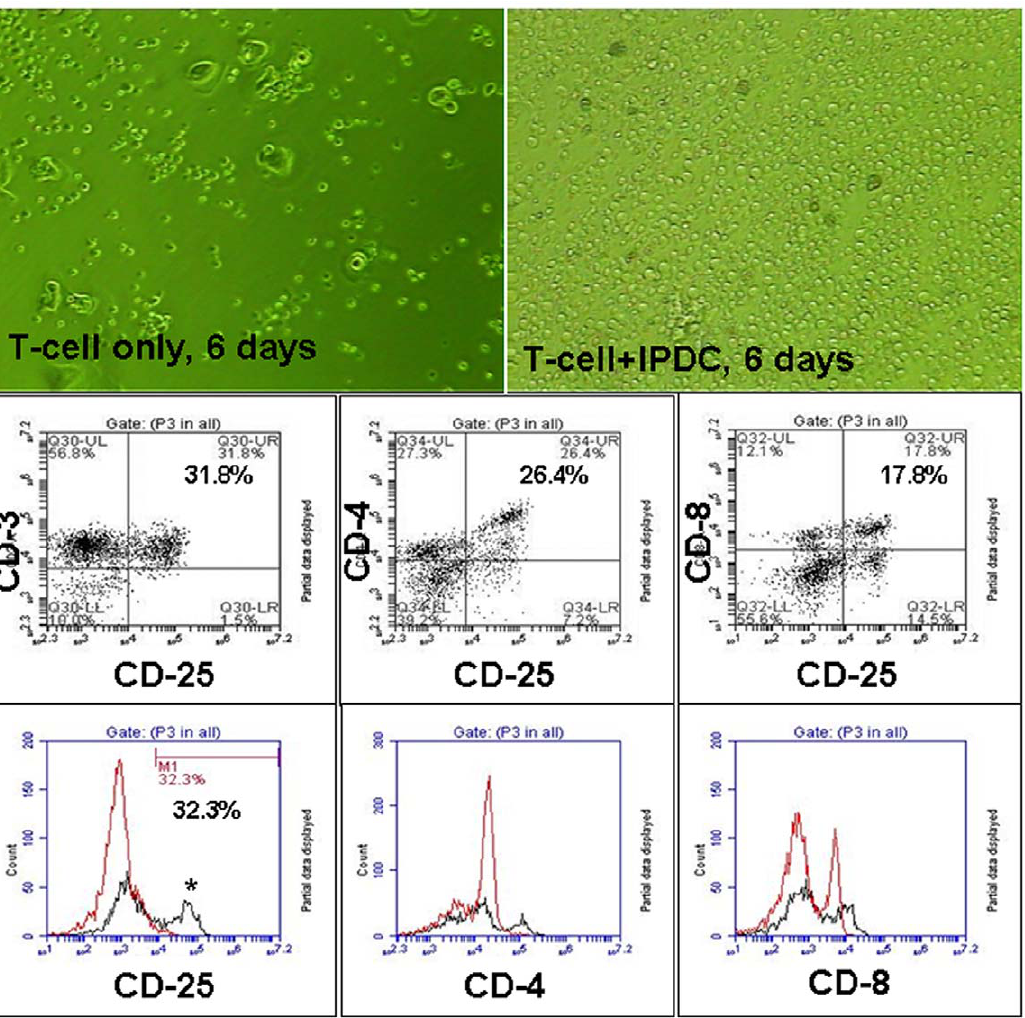
Figure 2. Morphological and phenotypical changes in T-cells during sensitization. Upper panel: Culture of cord blood derived T-cells in the absence (left) or presence (right) of U251 cell lysate primed irradiated DC (PIDC). T-cells were cultured in RPMI-1640 media containing 10% FBS and IL-2 for 6 days. Note the number and morphology of the sensitized T-cells (right). Middle panel: Dot plot analysis of flow cytometric data of the CTLs showing activated T-cells (CD25) that are also both CD4 and CD8 positive. Lower panel: Flow-cytometric analysis (histogram plot) of T-cells cultured in the absence (red line) and presence (black line) of PIDC for day 6. Note the higher number of CD4 + , CD8 + and CD25 + T-cells on day 6. There were a significantly (p=0.006) higher number of activated T-cells on day 6 in the presence of